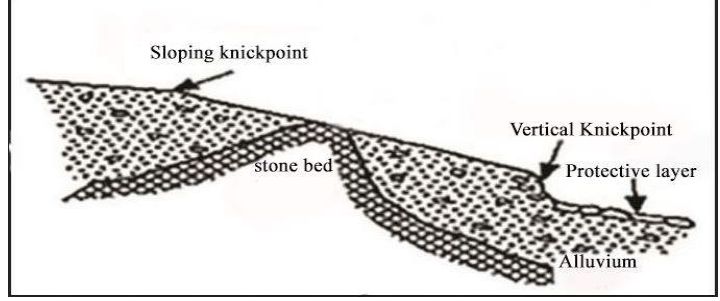
Figure 1. Inclined and vertical knickpoints (Julien,